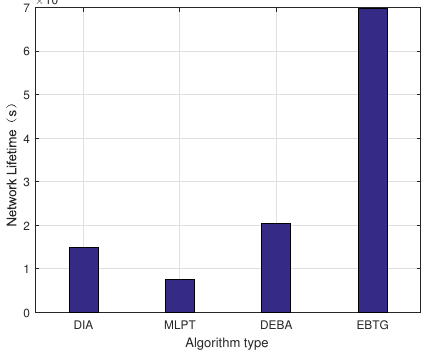
Figure 9. Network